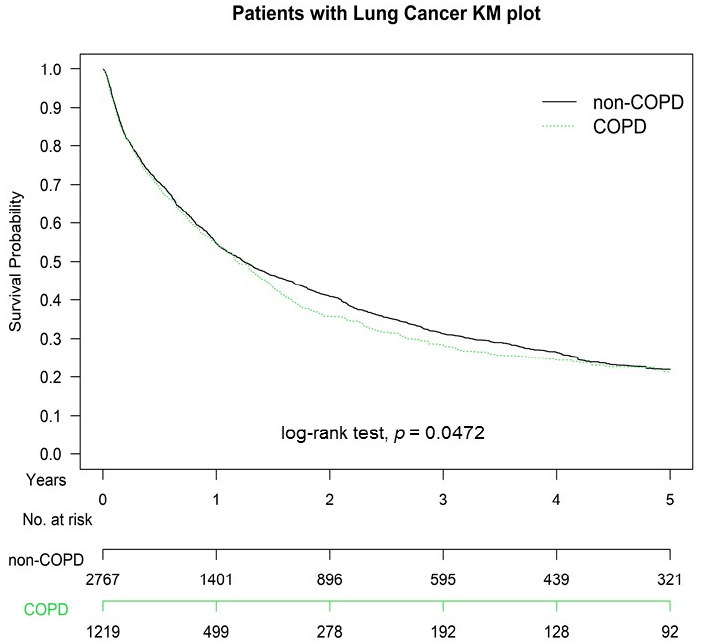
Figure 1. Kaplan-Meier overall survival curves of propensity score-weighted population of advanced stage lung squamous cell carcinoma with or without chronic obstruction pulmonary disease before concurrent chemoradiotherapy.